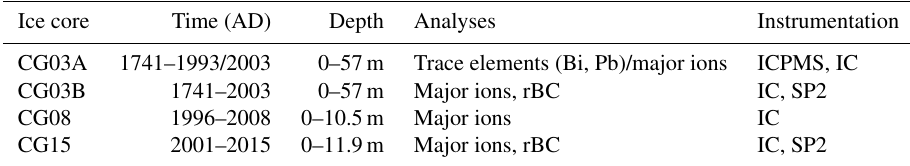
Table 1. Ice cores, parameters, and analytical